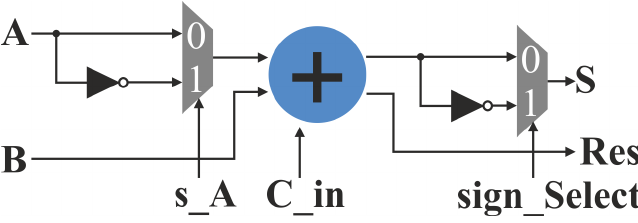
Figure 8. Adder for binarized